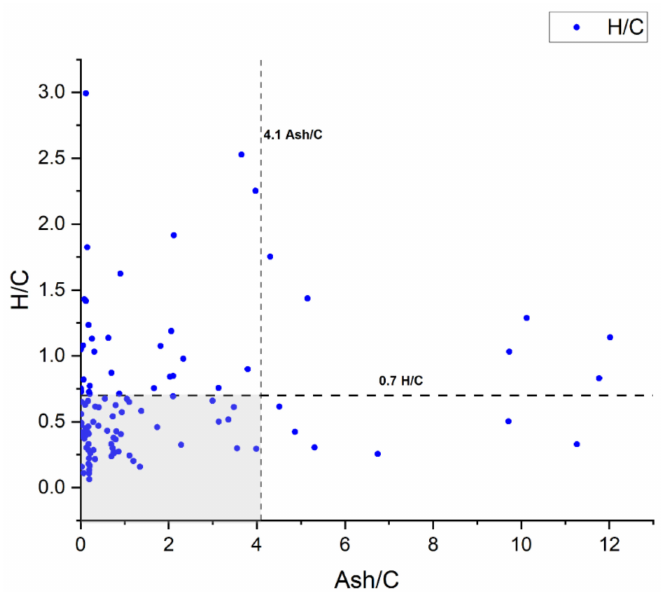
Figure 26. H/C molar ratio vs. A/C content. Shaded portion is defined as MAB (from Table